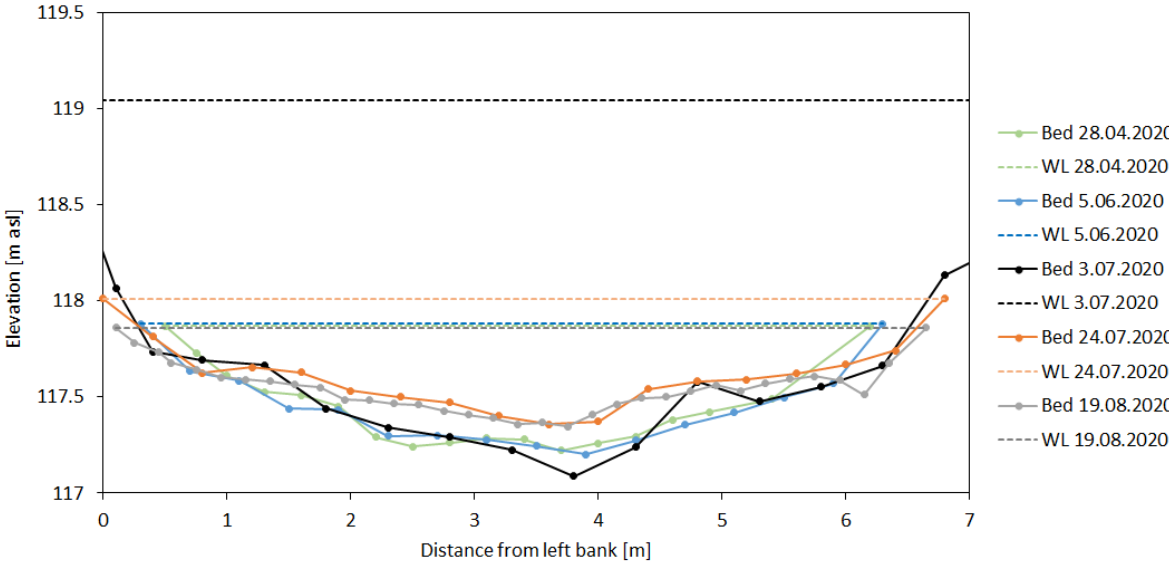
Figure 6. Channel bed morphology before (28 April and 5 May) and after (24 July and 19 August) the flood event at site M8. Solid lines show the cross-sectional channel bed elevation, and dashed lines show water level (WL) elevation on a given date.